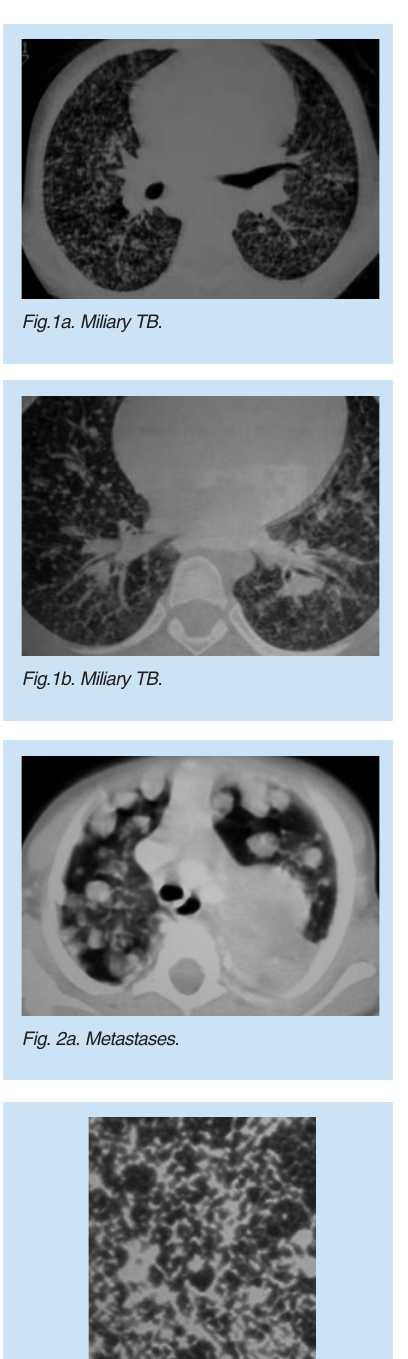
Fig. 2b. Centrilobar opacity (CLO).